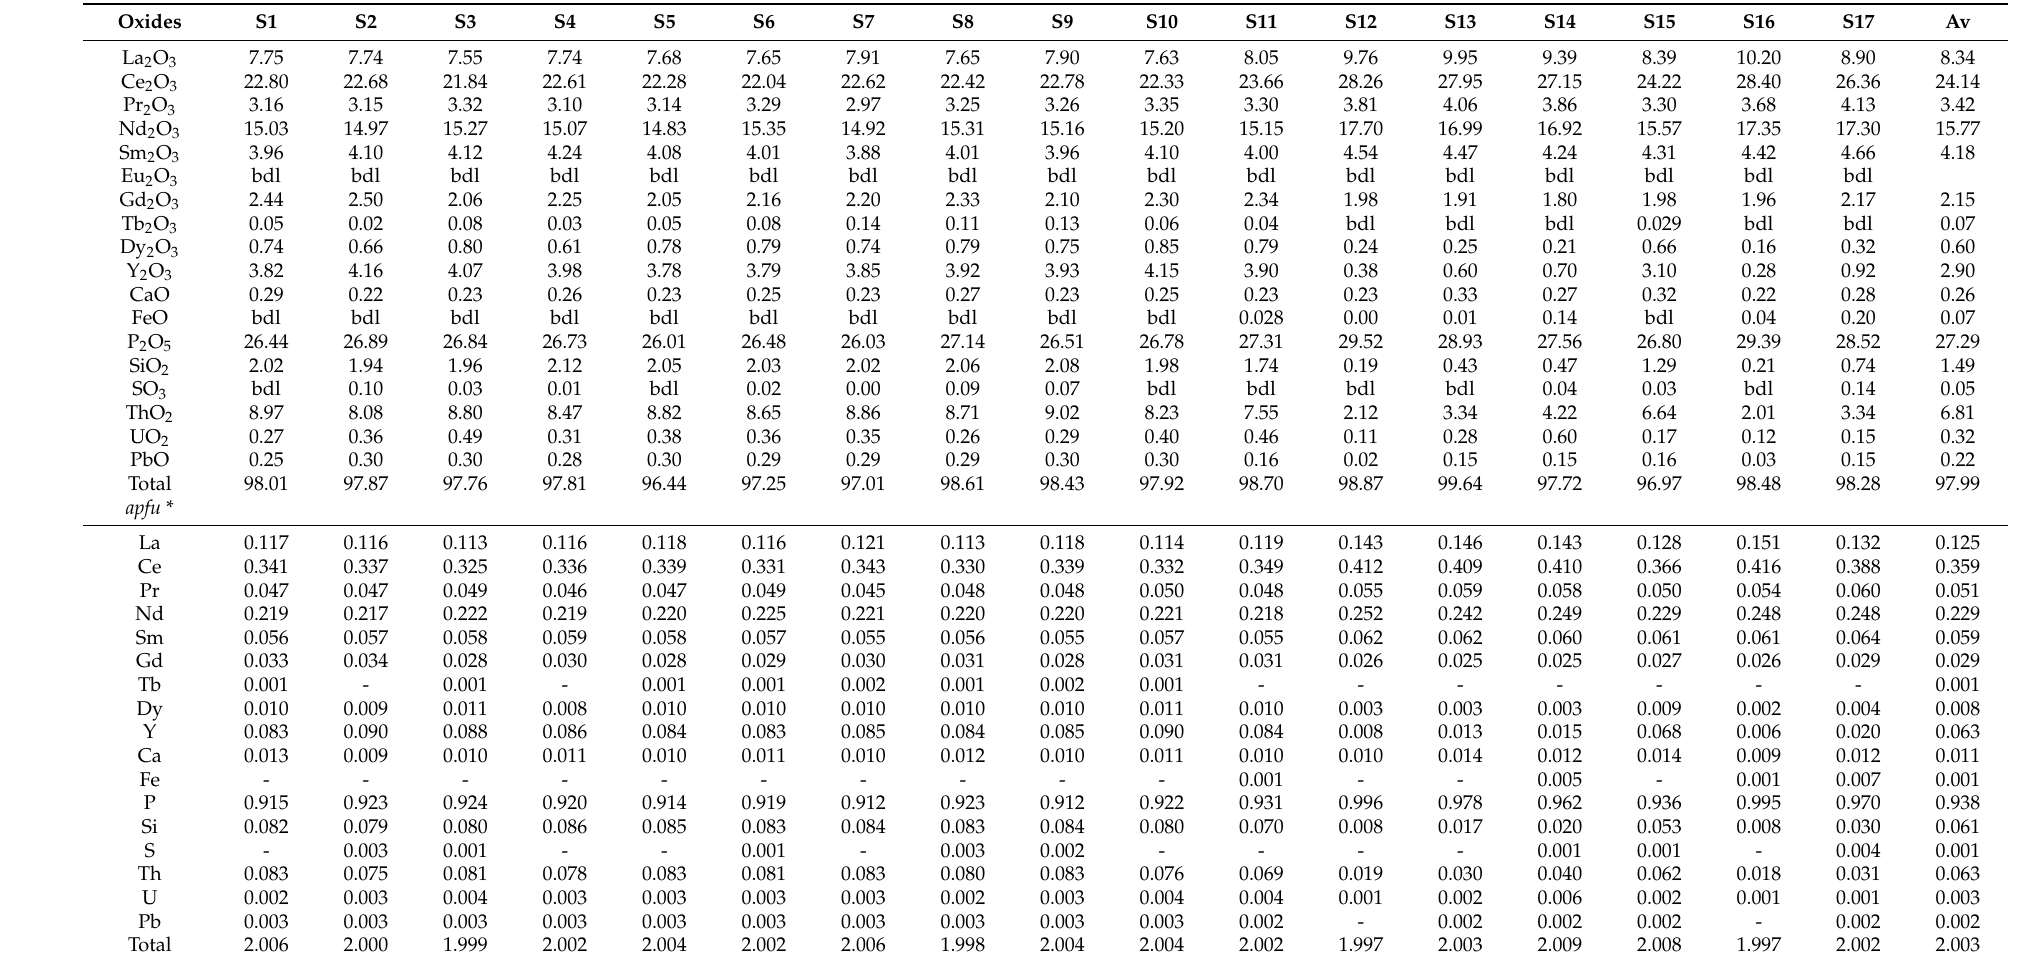
Table 2. Monazite-(Ce): EPMA data from 17 spots (S1 to S17) and their average (Av) for sample